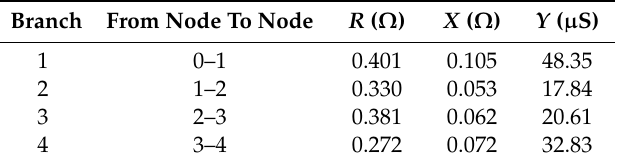
Figure 6. Electrical scheme of the feeder “MT L2” of the Favignana MV distribution network. Table 2. Line parameters of the “MTL2” MV feeder.